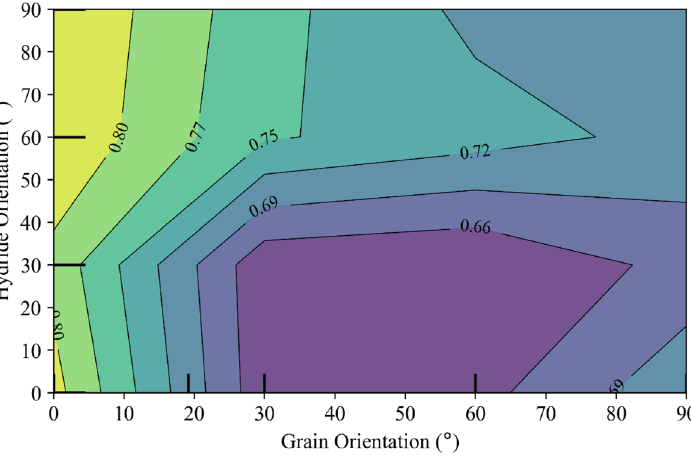
Figure 7. Partial dependence. The combined effects of grain orientation and hydride orientation are shown.